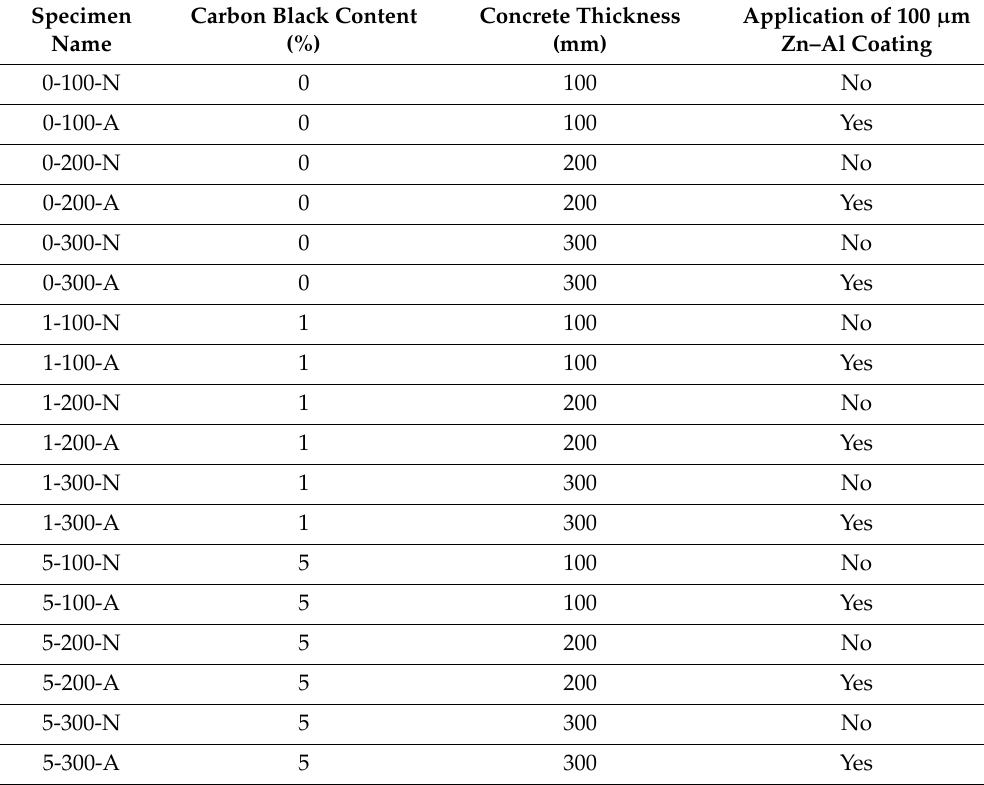
Table 1. Experimental